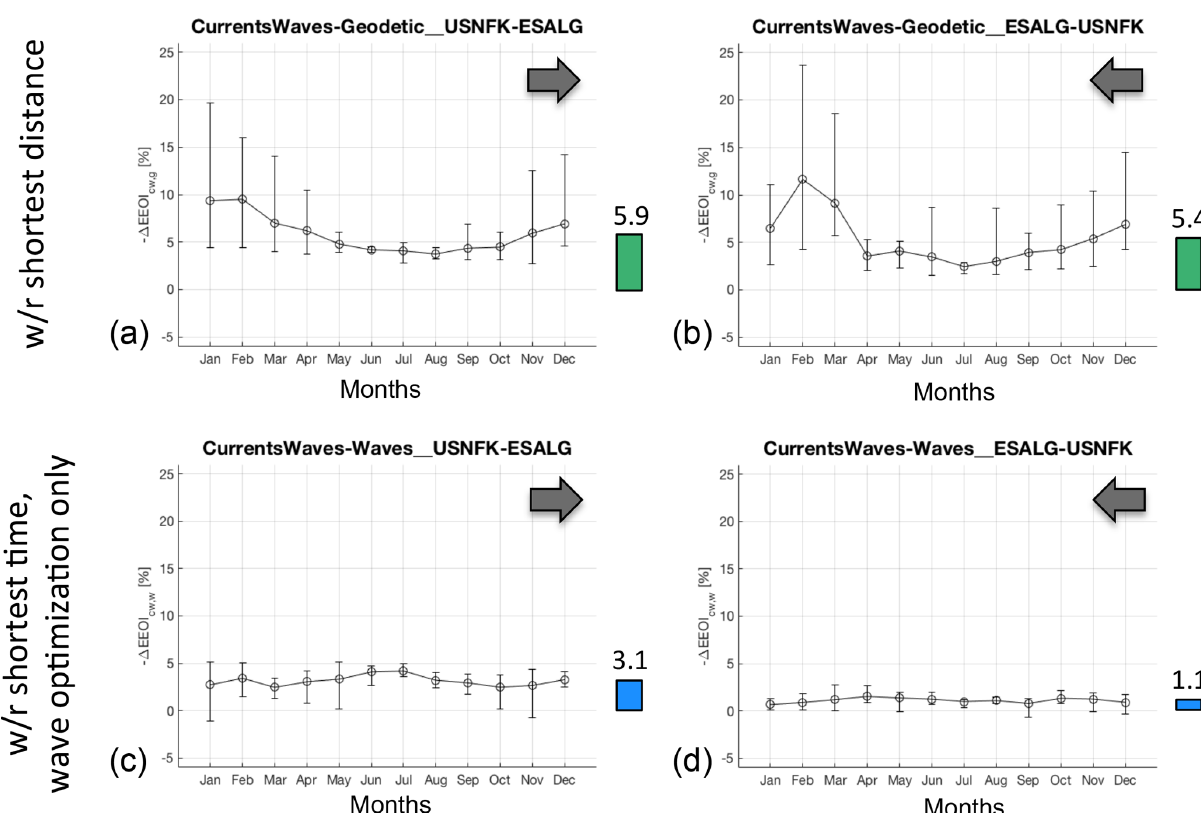
Figure 10. EEOI relative savings for the tracks in Fig. 7. The quantity defined in Eq. (18) is computed for optimal tracks of cw type vs. (a, b) the corresponding geodetic tracks and (c, d) vs. corresponding optimal tracks of w type. For each calendar month, the empty circle is positioned at the monthly average, and the error bars span between minimum and maximum value of the (six) routes of that month. w/r introduces the type of optimal track with respect to which the EEOI savings are